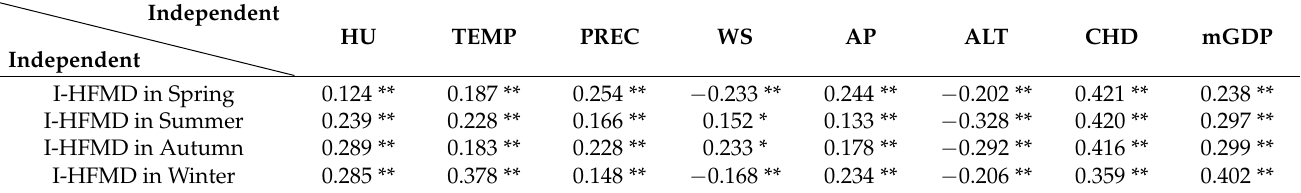
Table 3. Pearson correlations between the I-HFMD and eight potential risk factors for each season.